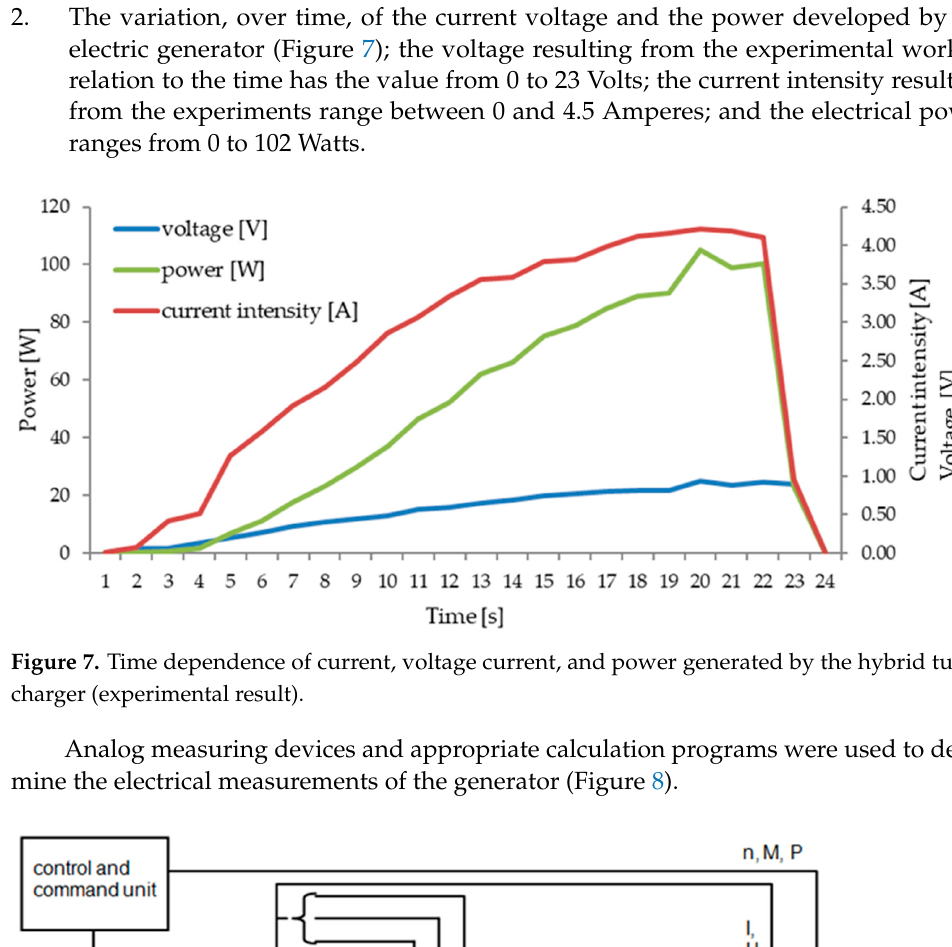
Figure 6. Turbocharger shaft speed variation (experimental result).